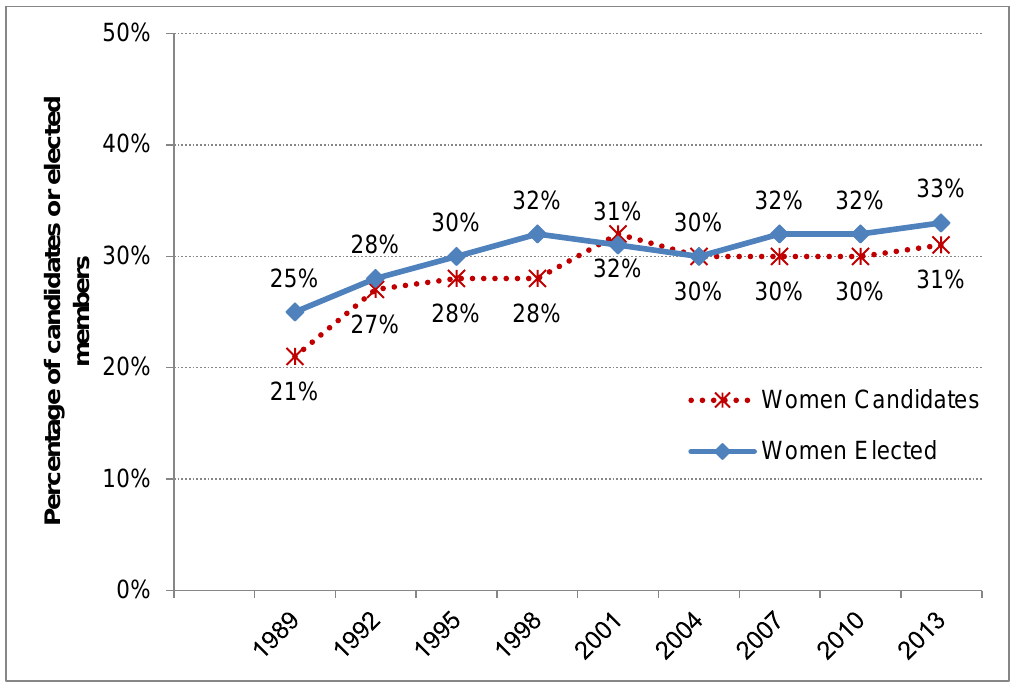
Figure 1: Pattern of women’s representation in New Zealand since 1989